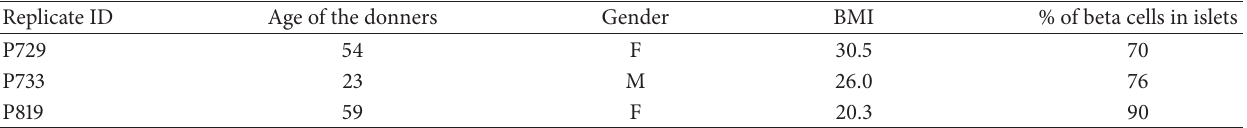
Table 2: Characteristics of the islet